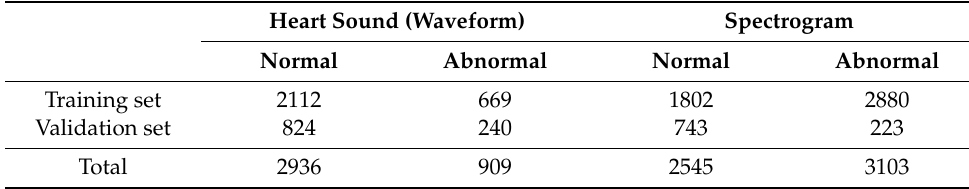
Figure 7. Abnormal train data augmentation. ( a ) Normal, ( b ) random noise, ( c ) left shift, ( d ) x-axis symmetry, ( e ) masking, ( f ) s&p noise.